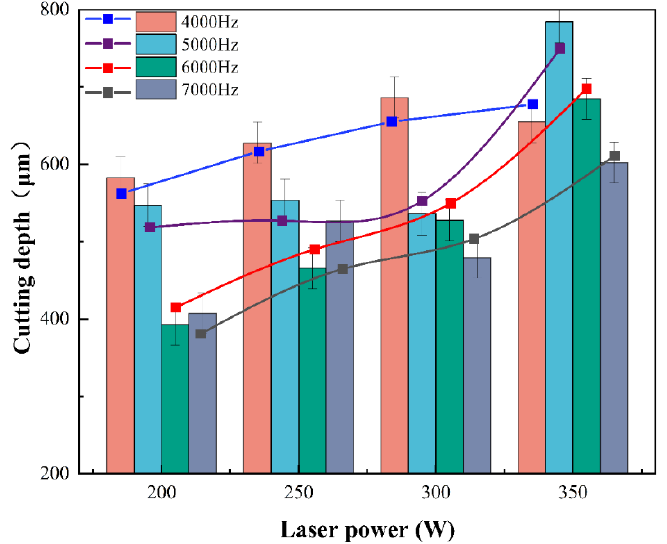
Figure 12. Average cutting depth at different laser powers and pulse frequencies.